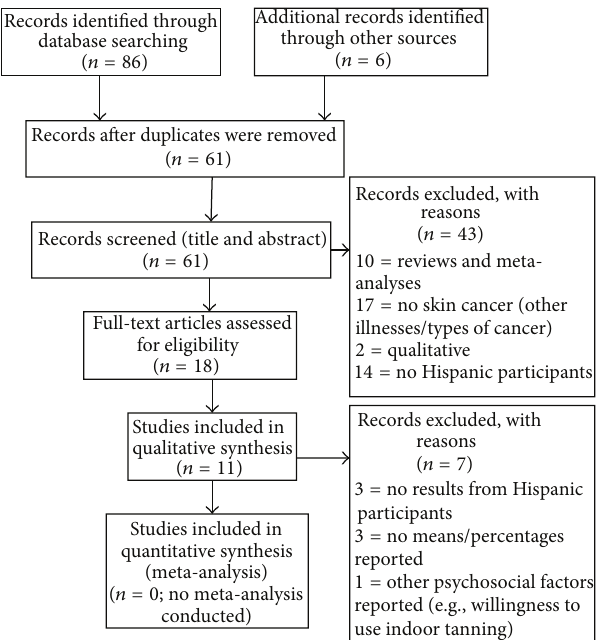
Figure 1: Flow diagram of literature